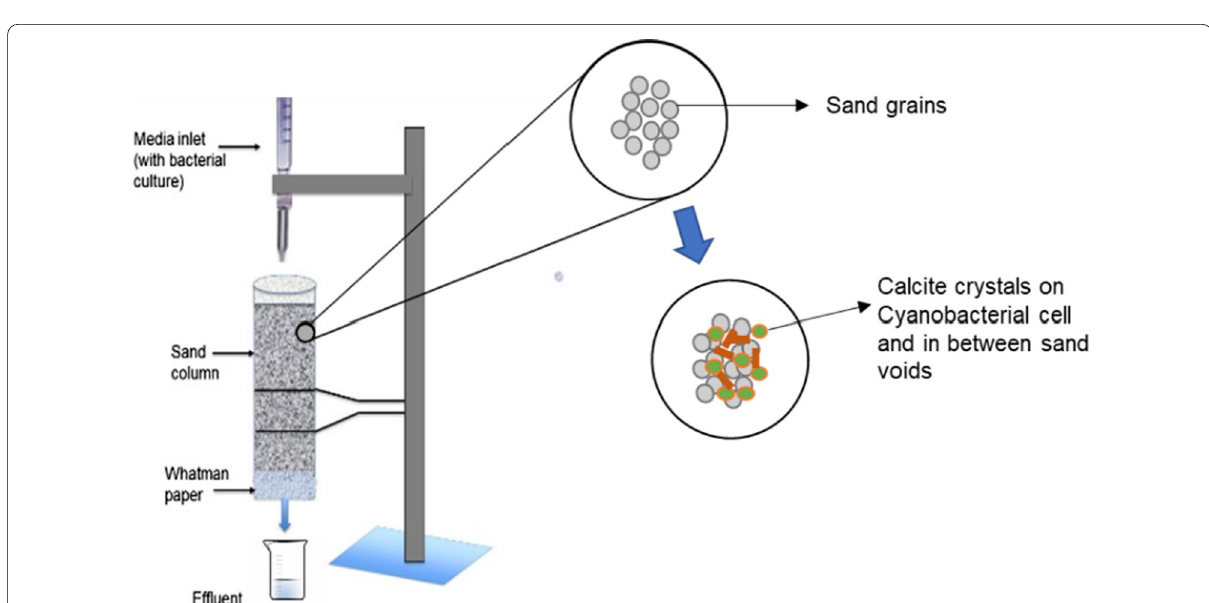
Fig. 1 Schematic representation of sand column